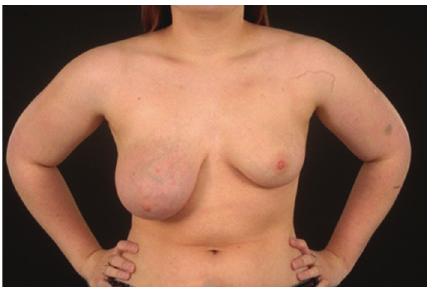
Figure 1: Figure demonstrating the asymmetry and the large mass in the right breast on presentation.